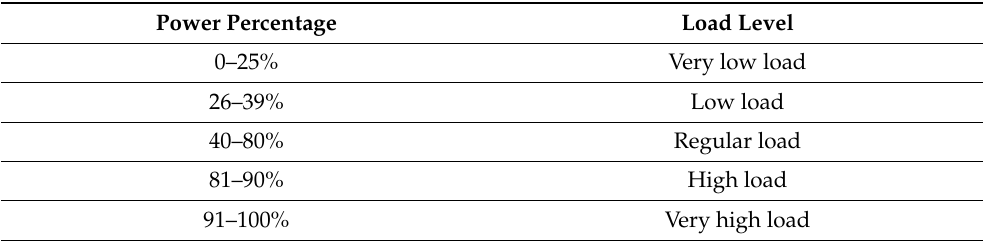
Table 2. Load levels as a percentage of rated